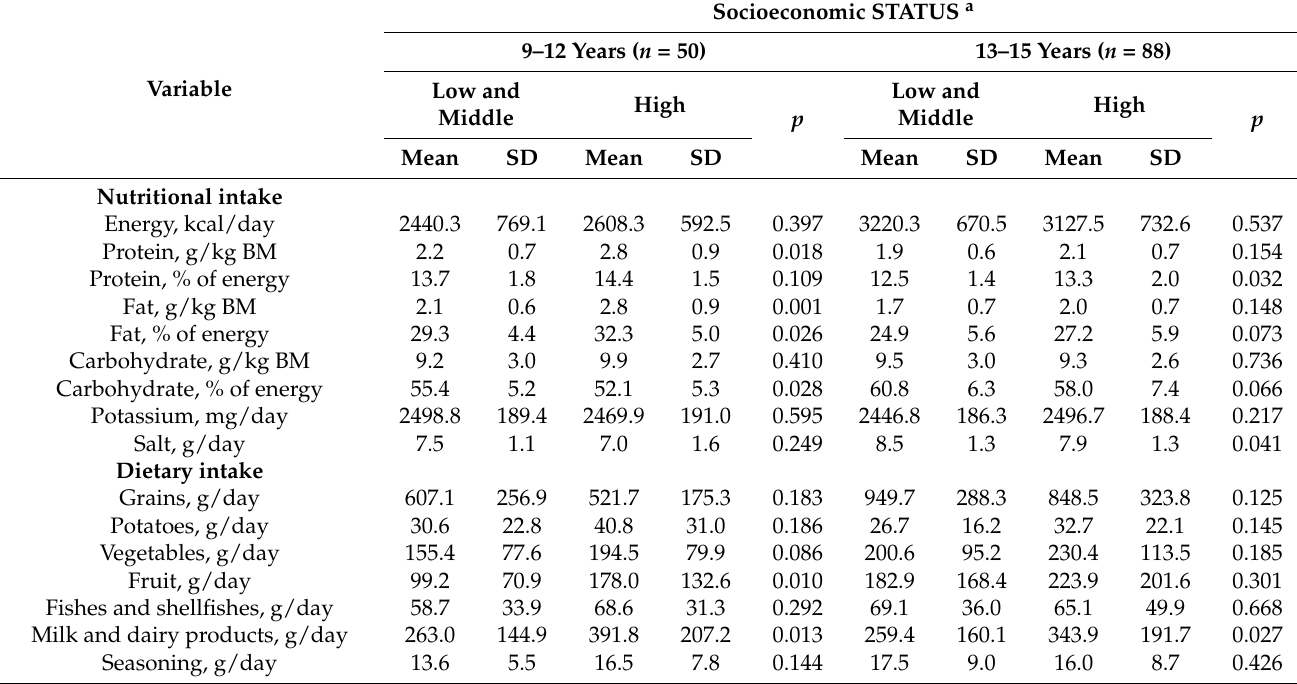
Table 5. Socioeconomic status compared with dietary intake by age